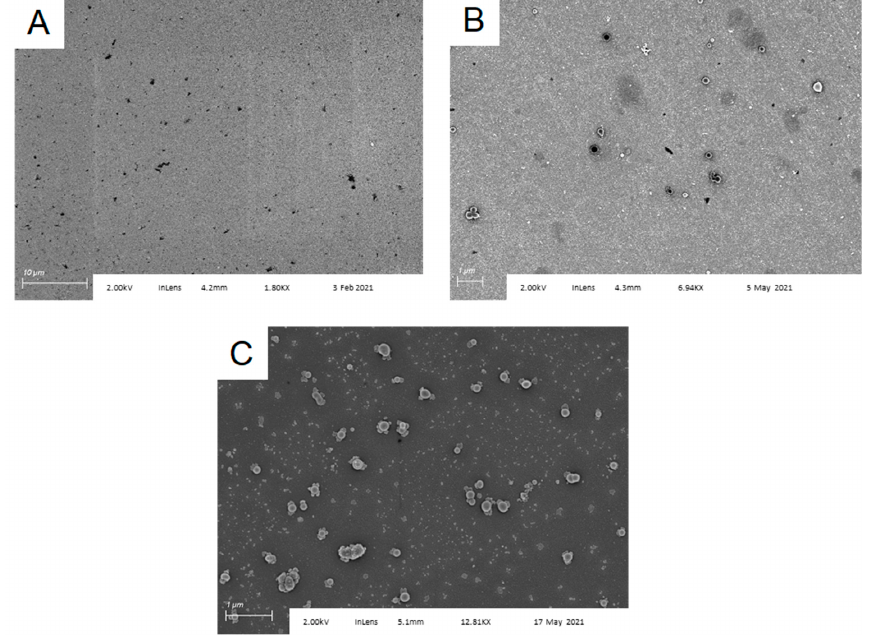
Figure 4. Bacillus subtilis spores are not captured by control surfaces functionalized with ( A ) APTES; ( B ) APTES followed by glutaraldehyde; and ( C ) APTES followed by glutaraldehyde, then anti-IL-6. Ambient dust or solution particulates coat the surface, but no spores are observed.